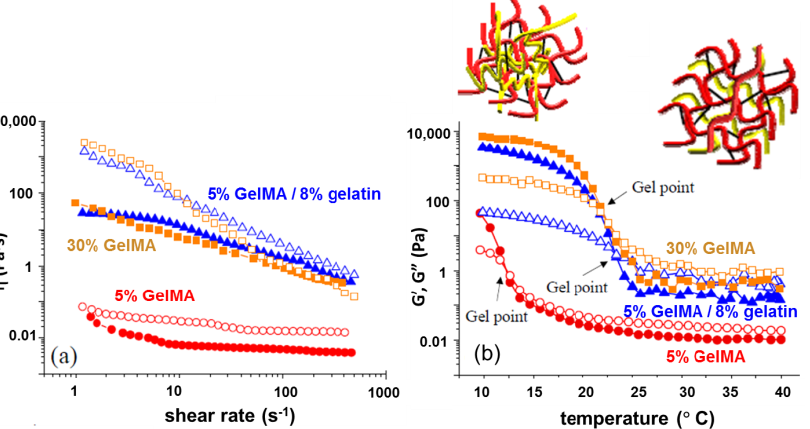
Figure 9. The rheological behavior of GelMA-based hydrogels: 5% GelMA, 5% GelMA/8% gelatin, and 30% GelMA. ( a ) shear viscosity as a function of shear rate at 15 °C (open symbol) and 25 °C (full symbol); ( b ) viscoelastic moduli as a function of temperature: G ′ (full symbol) and G” (open symbol). Adapted with permission from ref. [194] Copyright 2018 Americal Chemical Society.